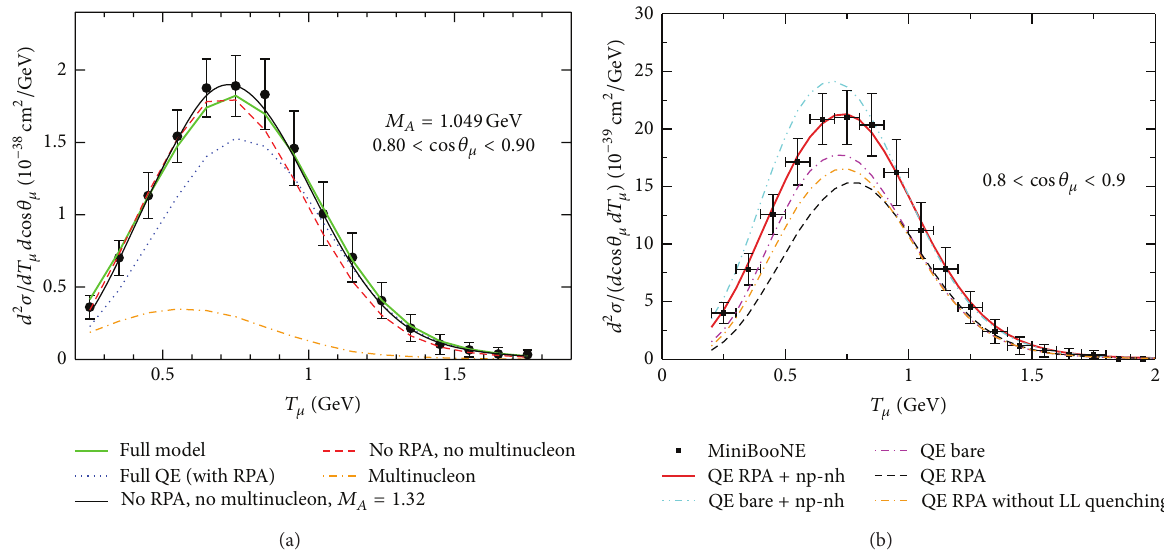
Figure 6: Comparison between the flux averaged muon energy spectrum at muon scattering angle 𝜃 𝜇 such that 0.8 ≤ cos 𝜃 𝜇 ≤ 0.9 , measured by the MiniBooNE collaboration [5] and the theoretical results of [34, 35] (thick solid line of (b)) and [36] (thick solid line of (a)). All theoretical calculations have been carried out using a value of the axial mass consistent with the one extracted from deuteron data.